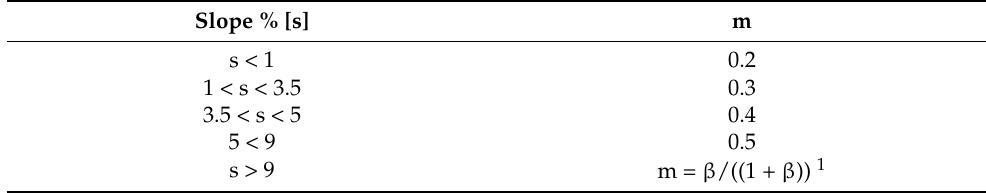
Table 1. Values of dimensionless factor m. Slope % [s]